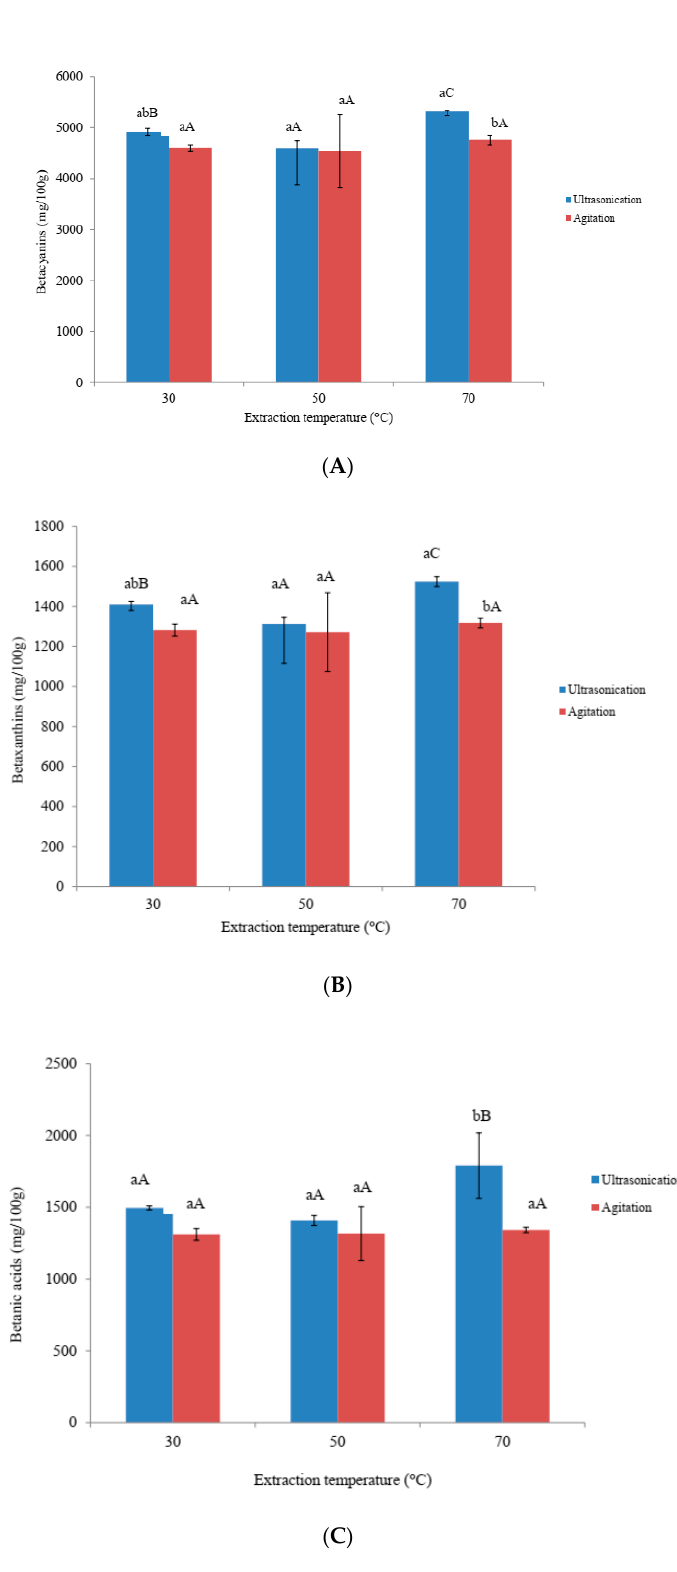
Figure 4. E ff ects of ultra-sonication and agitation on Betacyanins content, Betaxanthins content and Betanic acids of amaranth extract. ( A ) Betacyanins content ( B ) Betaxanthins content ( C ) Betalamic acid. a–b Means with same subscript alphabets are not significantly di ff erent ( p ≤ 0.05) between each extraction method. A–C Means with same subscript alphabets are not significantly di ff erent ( p ≤ 0.05) among di ff erent temperatures in each extraction